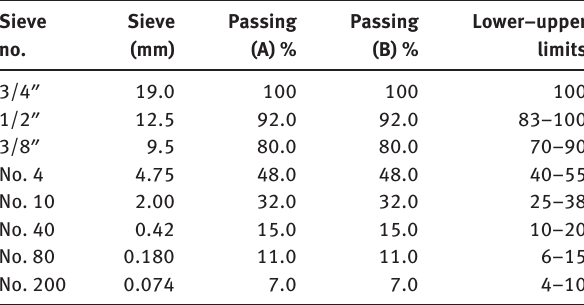
Table 2 Selected design gradation of the aggregate specimens.